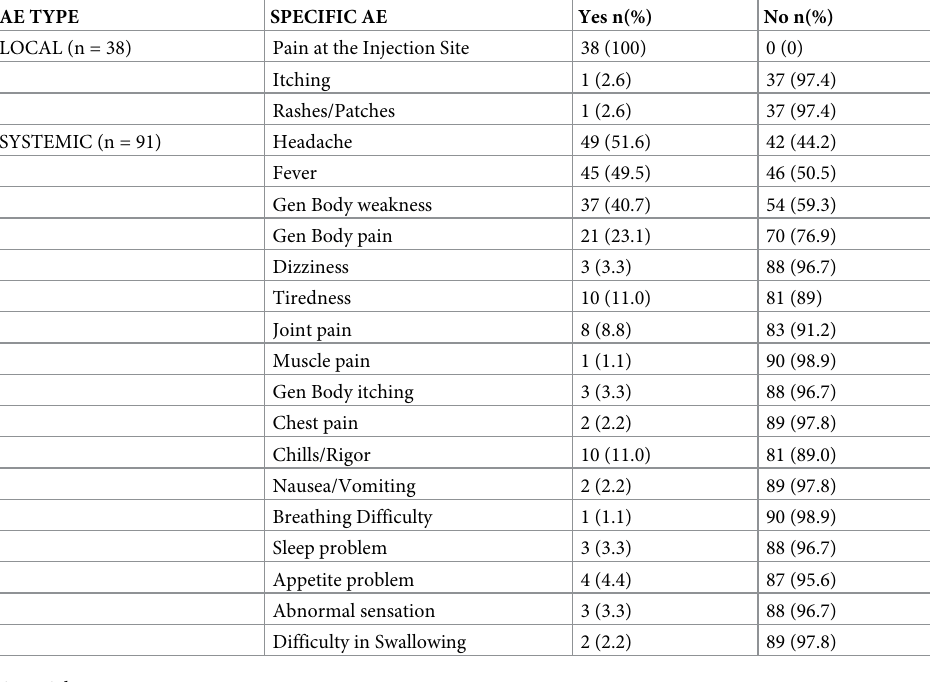
Table 3. Specific local and systemic adverse